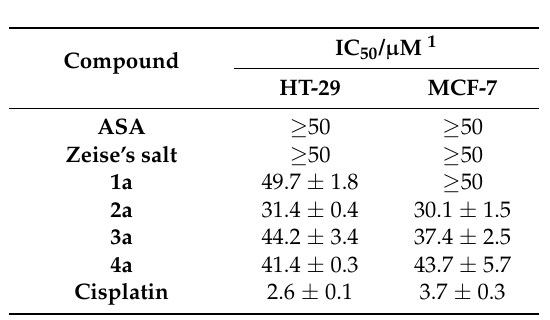
Table 3. Inhibition of the cell growth in colon carcinoma (HT-29) and breast cancer (MCF-7) cell lines determined in a crystal violet cell biomass